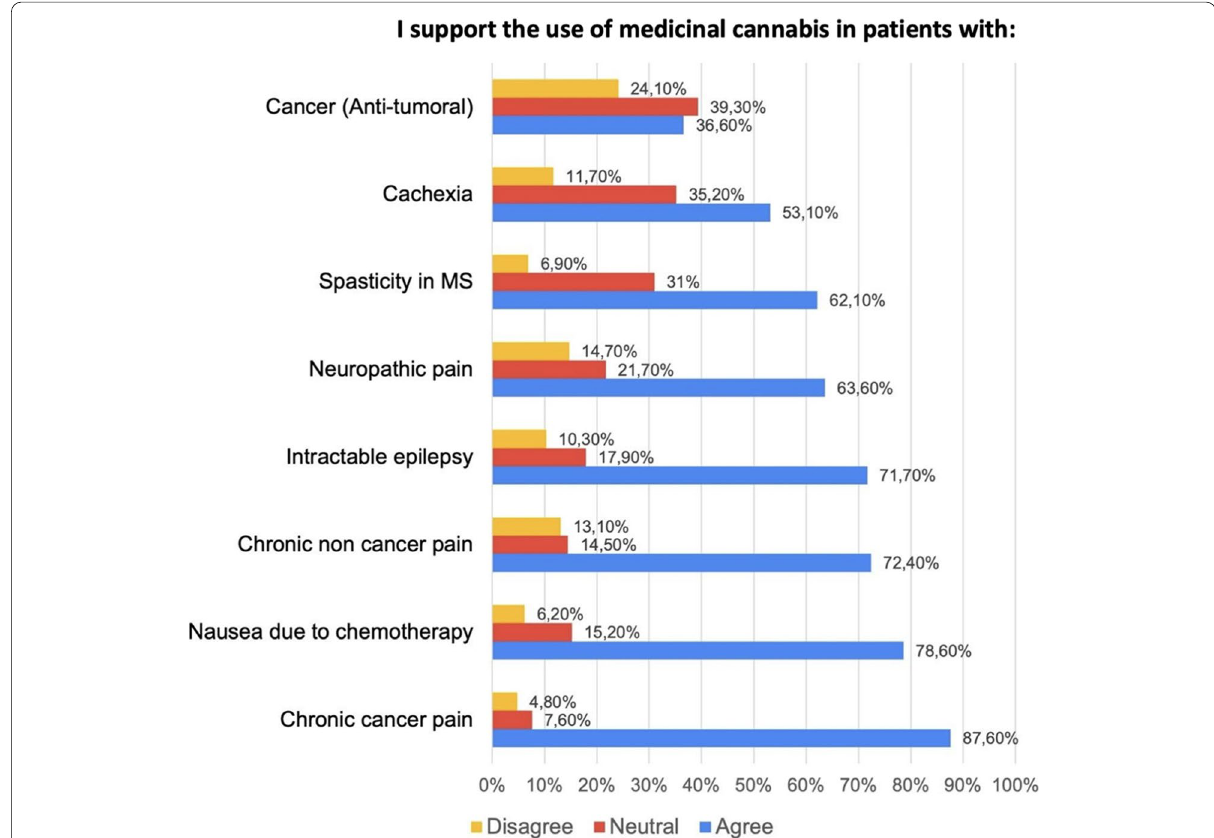
Fig. 3 Support for use of medicinal cannabis in non‑mental health conditions among 145 Colombian psychiatrists. The non‑mental health condition with the highest approval for the use of MC was chronic cancer pain and the one with the most disapproval was antitumoral effect. MC, medicinal